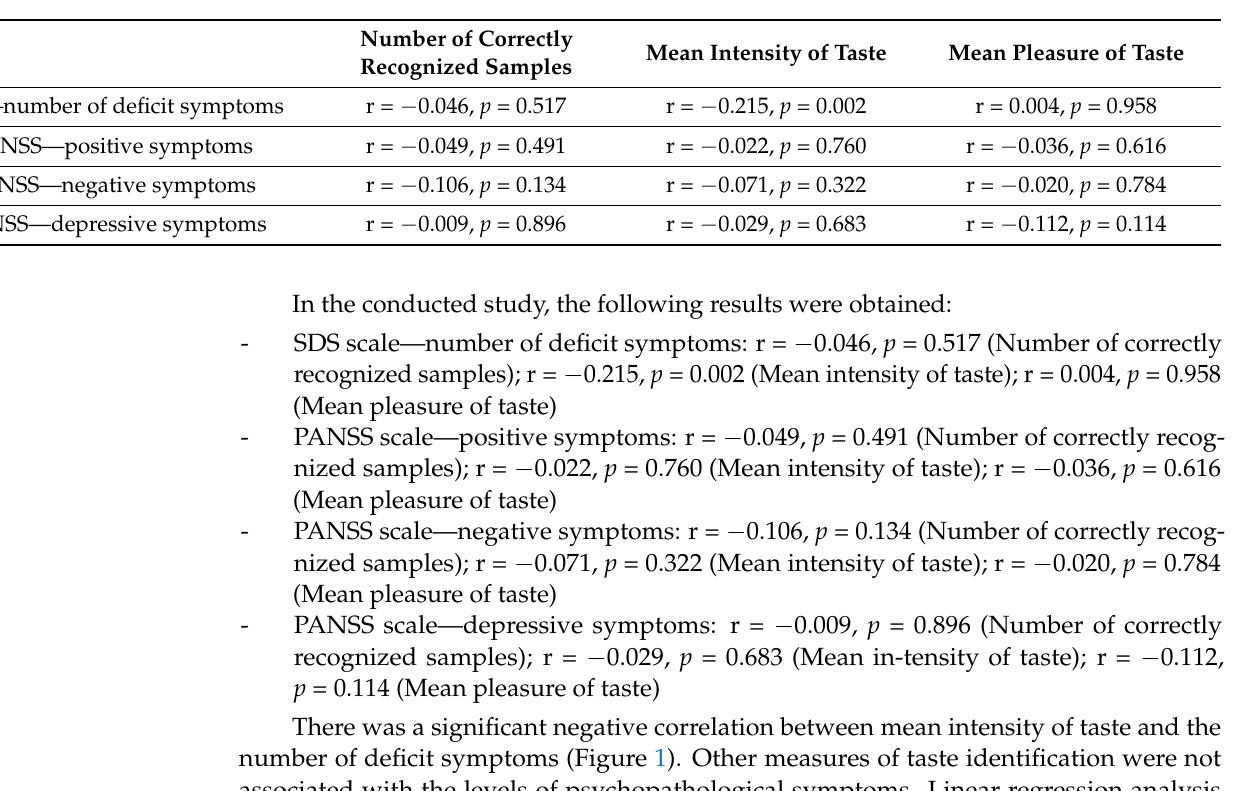
Table 3. Results of taste identification tests with respect to psychopathological manifestation.